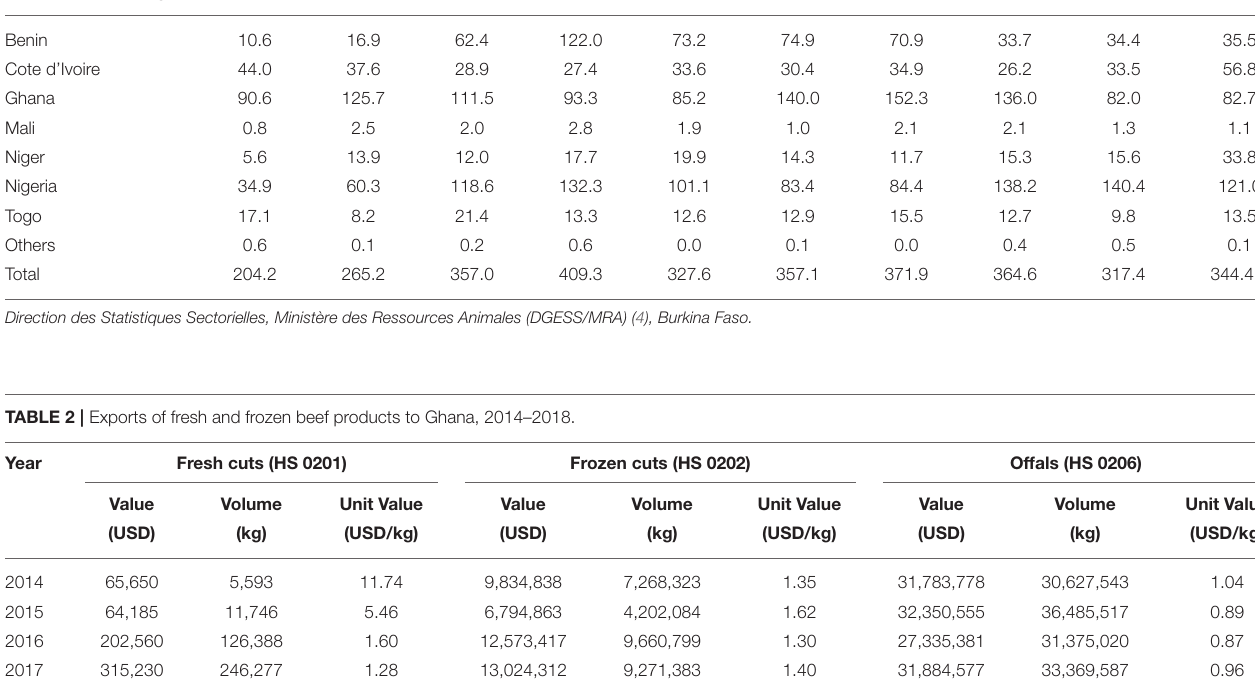
TABLE 1 | Exports of live animals from Burkina Faso to regional markets, 2005–2014 (thousand heads). Destination country